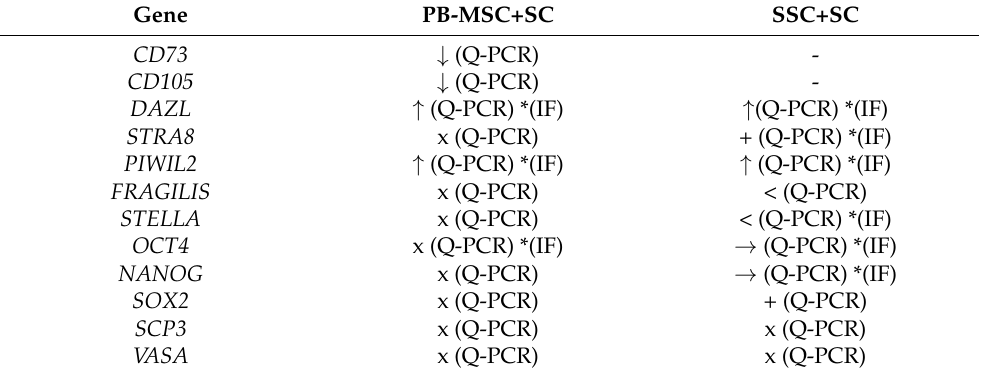
Figure 3. Expression of pluripotency markers NANOG , OCT4 and SOX2 in single cultures and co-cultures of PB-MSC and SSC with SC in 3D SACS for 21 days. ( A ) Expression levels of NANOG were similar ( p > 0.05) in SSC+SC co-culture compared to SC single culture on day 14. ( B ) Co-culture of PB-MSC+SC up-regulated OCT4 gene expression on day 7 compared to SC and PB-MSC single cultures. ( C ) SOX2 gene expression was detected in SC on day 7 and on day 14 in co-cultures of SSC+SC. ( D ) More intense immunofluorescence associated to NANOG was observed in SSC+SC co-cultures at day 14. ( E ) Similarly, more intense immunofluorescence associated to OCT4 was observed in SSC+SC co-cultures at day 14. (*) Indicate gene expression was not detected in a single sampling day. Different superscripts (a, b, c) indicate significant differences ( p < 0.05) for the same marker between cell types and (1,2) for the same marker between culture days. Table 2. Gene expression pattern of mesenchymal, pluripotency, GC and male GC genes in bull co-cultures of PB-MSC and SSC with SC in 3D SACS at day 14 compared to single cultures of MSC, SC and